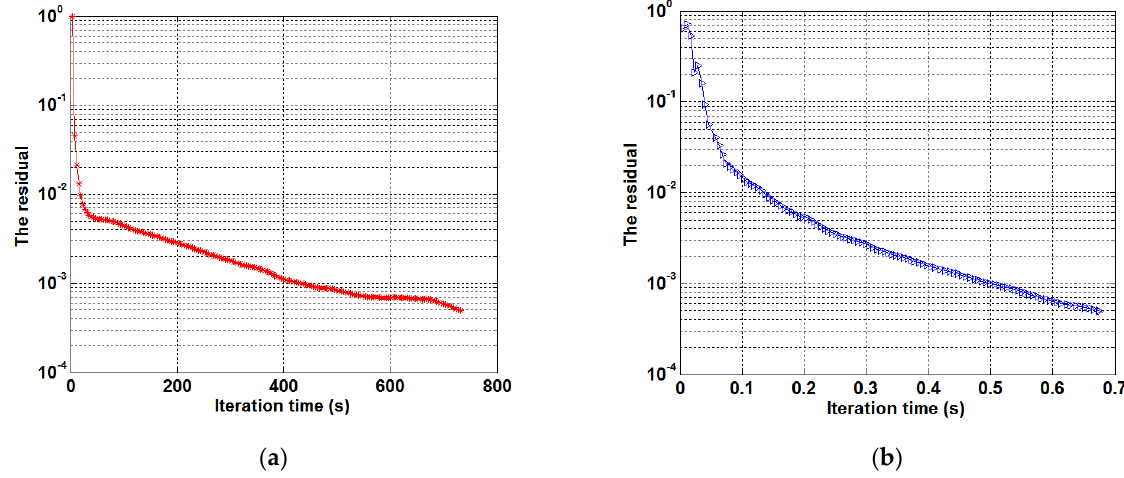
Figure 5. Comparison of the computation time for different algorithms. ( a ) TCS-SAR. ( b ) Proposed algorithm.